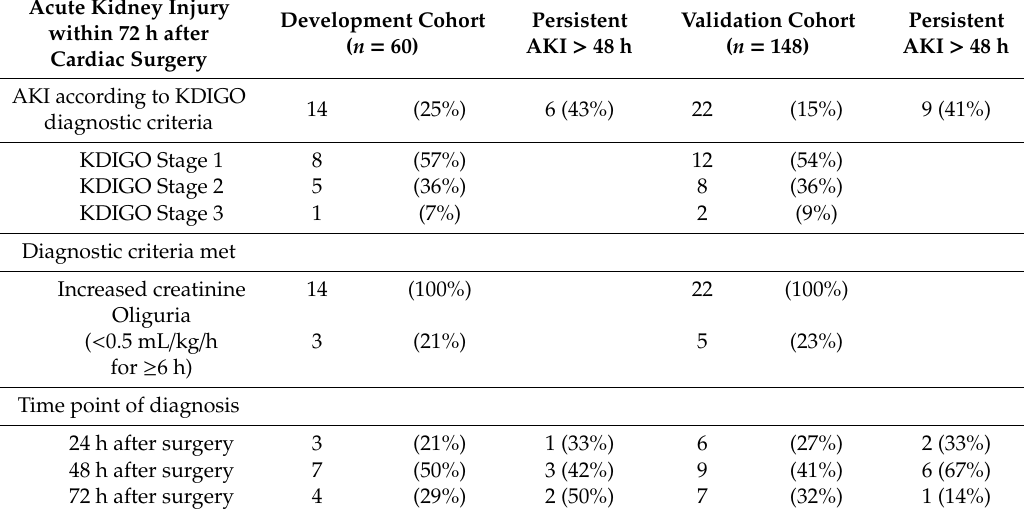
Table 1. Incidence, diagnostic criteria, and time point of diagnosis of AKI by cohort. Categorical data are presented as the absolute number and percentage. Diagnosis of AKI was based on Kidney Disease Improving Global Outcomes (KDIGO) clinical practice guidelines ((1) an increase in serum creatinine of at least 0.3 mg / dL or an increase of 50% above baseline and / or (2) a decline in urine output to below 0.5 mL / kg / h for at least 6 h) [16]. Most patients diagnosed with AKI were a ff ected by AKI stage 1 and were diagnosed 48 h after surgery. All patients su ff ering from AKI showed an increase in serum creatinine. Approximately 40% of AKI patients had persistent AKI lasting > 48 h. AKI, acute kidney